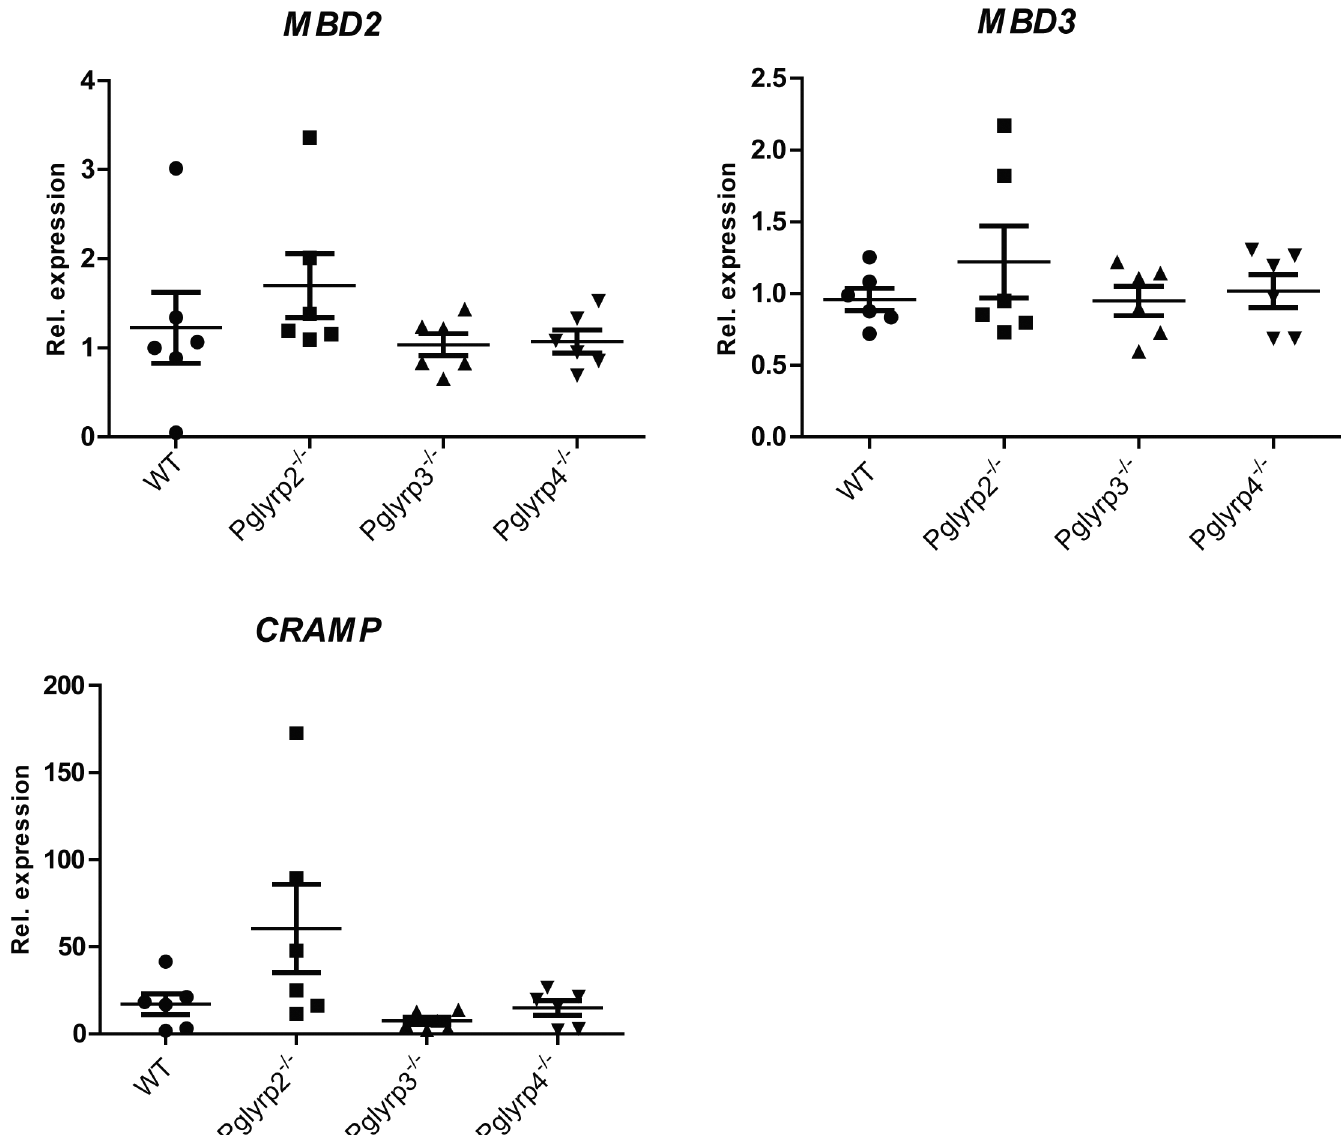
Fig 6. mBD2 , mBD3 and Cnlp (CRAMP) gene expressions. The results show expression fold change (2 - ΔΔ Ct ) ± SEM of defensins and CRAMP mRNA relative to Hprt in total RNA from Pglyrp- 2 -/- , Pglyrp- 3 -/- , Pglyrp- 4 -/- whole eyes (6 animals per genotype). Expression of mBD2 , mBD3 and most notably CRAMP was increased in infected Pglyrp -2 -/- eyes compared to WT without reaching statistical